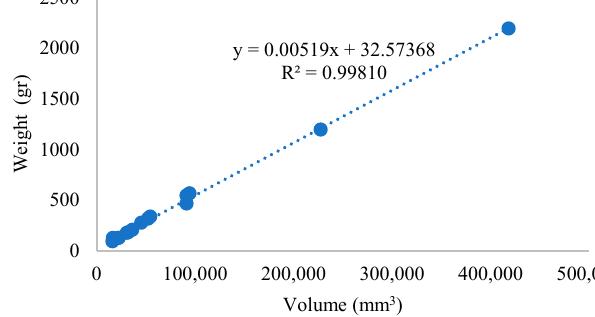
Figure 15. The weight and volume relationship.